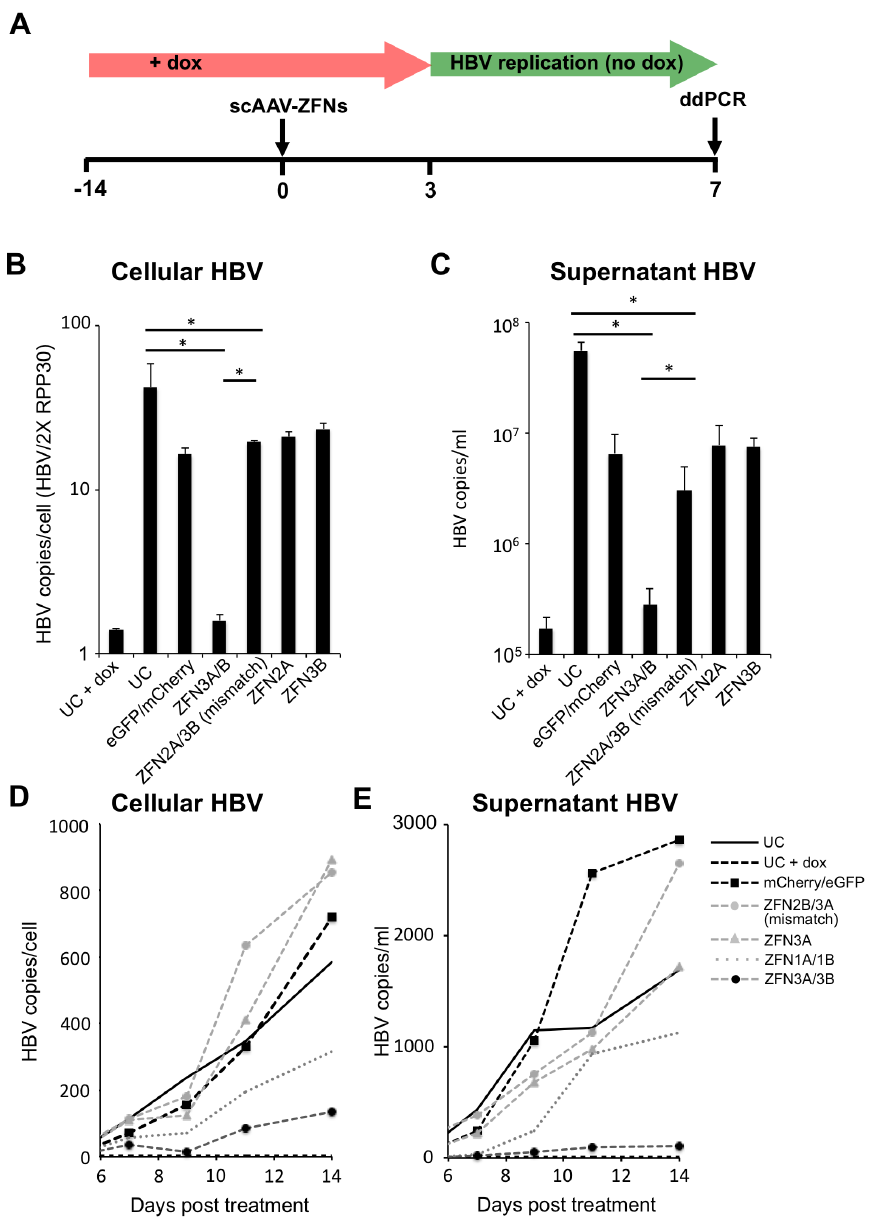
Figure 6. Levels of HBV DNA present in ZFN-treated HepAD38 cells and levels of secreted infectious HBV. ( a ) For experiments shown in panels b and c , HepAD38 cells in the presence of dox were transduced with ZFN- or control-expressing scAAV2 vectors (total MOI 10000 genomes/ cell) and 3 days later dox was removed from culture medium to enable HBV replication. Cells were left in culture for a further 7 days before HBV genomic levels were quantified in cells ( b ) and infectious HBV levels were quantified in supernatants ( c ) by ddPCR. ( d–e ) HepAD38 cells were passaged every two to three days over the course of 14 days following treatment with ZFN- or control-expressing scAAV vectors and monitored for cellular ( d ) and supernatant ( e ) HBV levels by ddPCR. ddPCR – droplet digital polymerase chain reaction; dox – doxycycline; eGFP – enhanced green fluorescent protein; scAAV – self-complementary adeno-associated virus; UC – untreated control; ZFN – zinc finger nuclease. *p # 0.05.